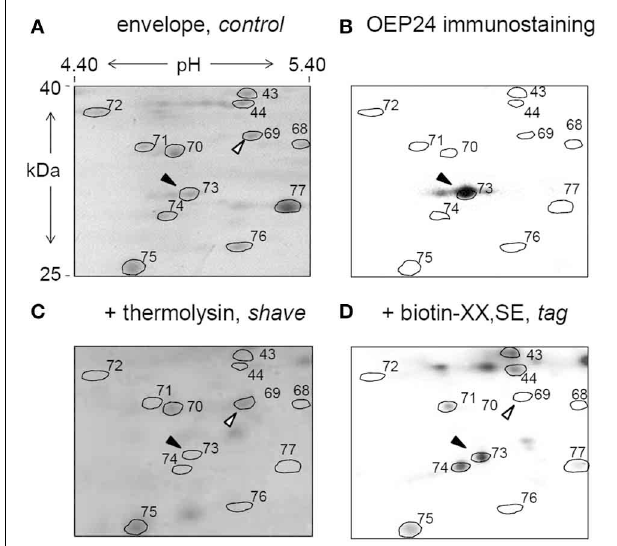
FIGURE 5 | Chloroplast envelope tag and shave. Isolated chloroplasts were either untreated (control), treated with the non-permeable thermolysin protease (shave) or superficially biotinylated (tag), prior to envelope fractionation. Envelope proteins were subsequently resolved by 2D-PAGE as shown in Figure 2 . Proteins were either stained with Coomassie blue (A,C) or transferred to a nitrocellulose membrane for Western-blotting using a specific markers of the outer envelope membrane, anti-OEP24 (B) or for biotin detection (D) . A magnified detail of the gel is shown. Spot 73 that corresponds to OEP24 (black arrow) is detected with the antibody raised against OEP24 (B) , and is consistently degraded (shaved) by the thermolysin protease (C) and biotinylated (tagged) by the biotin-XX,SE treatment. As a control, spot 69 (white arrow) is neither shaved nor